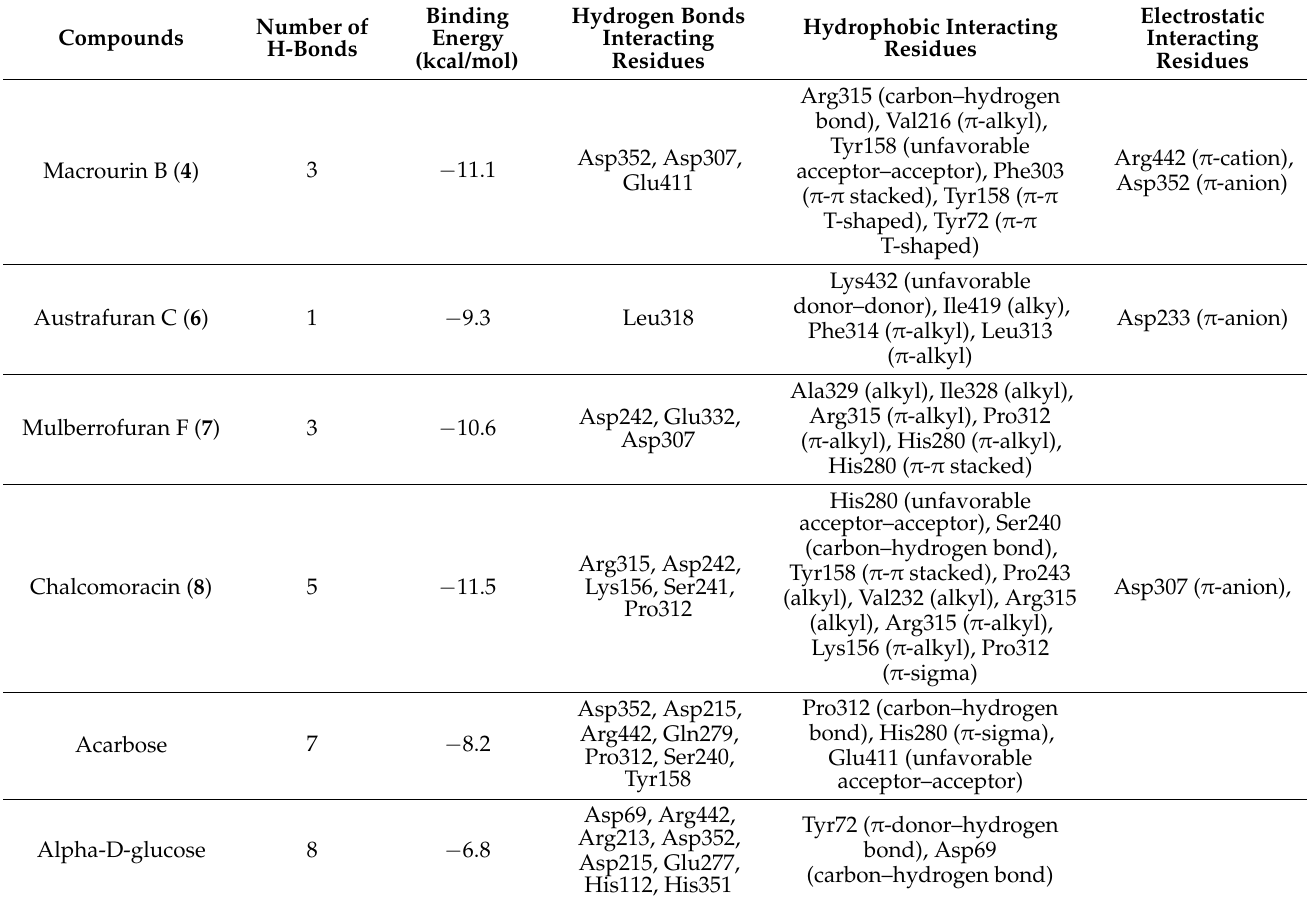
Table 5. Binding site residues and docking scores of compounds in the α -glucosidase using the AutoDock Vina 4.2